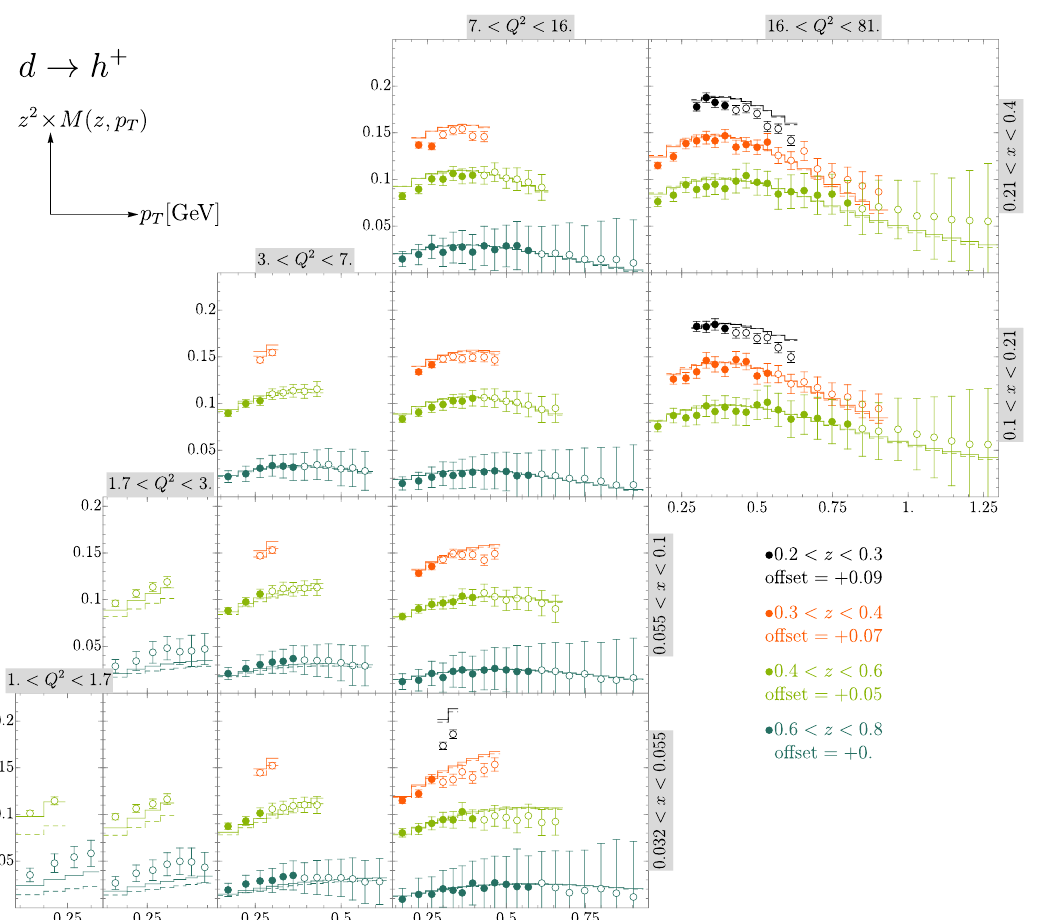
Figure 20 . Unpolarized SIDIS multiplicities (4.4) (multiplied by z 2 ) for production of negatively charged hadrons o(cid:11) deuteron measured by COMPASS in di(cid:11)erent bins of x , z , Q and p T . Solid (dashed) lines show the theory prediction at NNLO (N 3 LO). Filled (empty) points were (not) included in the (cid:12)t of NP parameters. For clarity each p T bin is shifted by an o(cid:11)set indicated in the legend. The continuation of the picture is in (cid:12)gure 21.